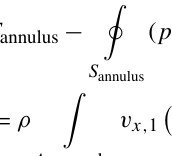
and downstream limits. The momentum balance Eq. (37) yields the wake velocity v x, 1 , annulus which, combined with the mass